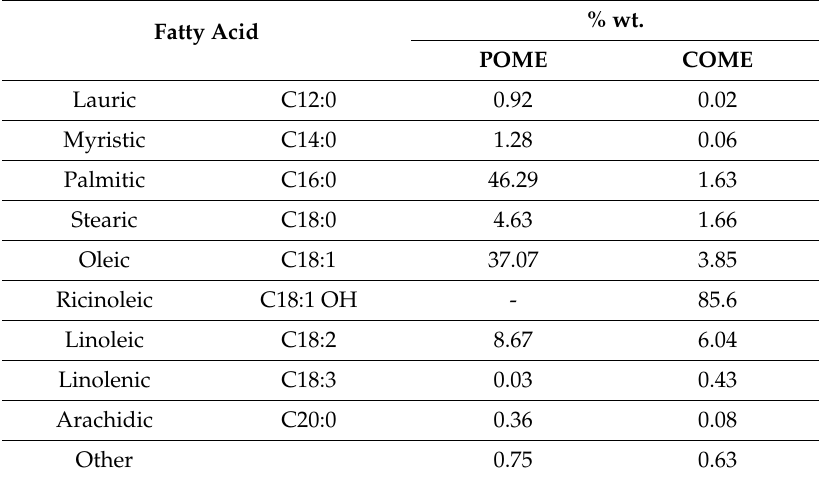
Table 2. Fatty acid composition of palm oil and castor